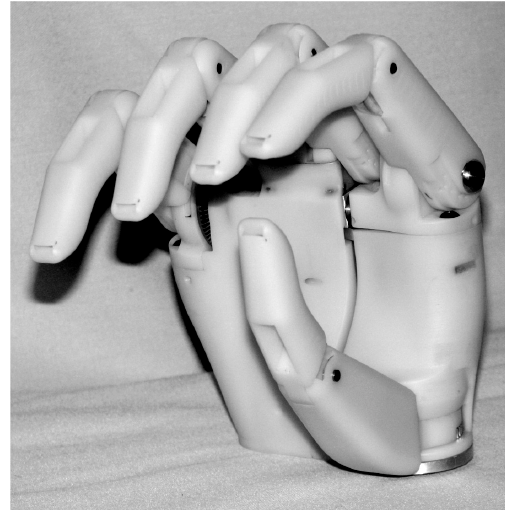
Figure 3. The design of the UNB hand. it incorporates three mo- tors to actuate five fingers, the thumb with two separate motions.